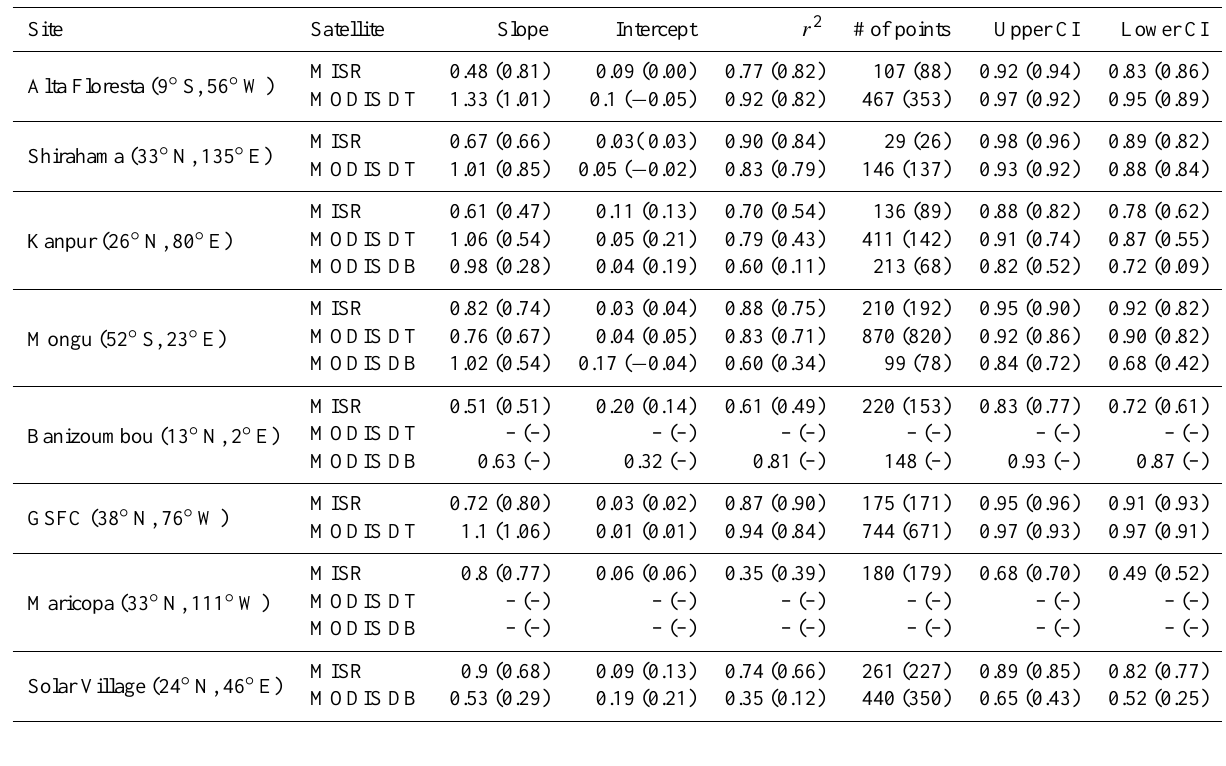
Table 1. Regression coefficients and 95% confidence interval (CI) for correlation coefficients in Fig. 1 with all AOD and satellite AOD smaller than 0.5 in parentheses. No statistics are shown when number of points are smaller than 25.